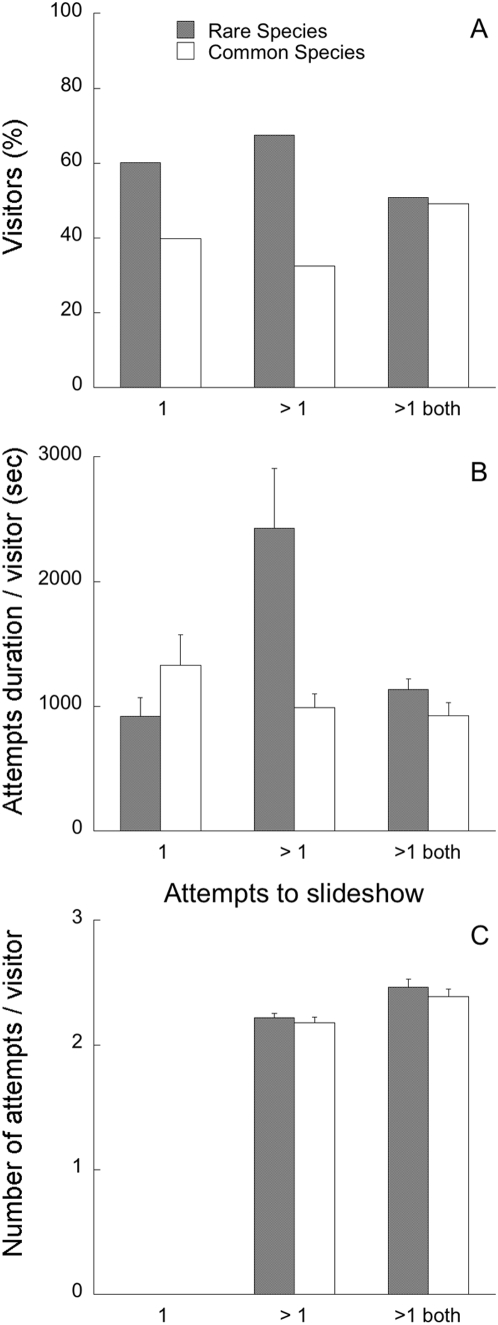
Behaviour of visitors having to choose between slideshows of rare or common species.We show (A) attractiveness, (B) patience and (C) perseverance of visitors. Data comes from visitors who attempted to open only one slideshow type, once (1) or multiple times (>1), or their first choice when they attempted to open both slideshows (>1 both). Error bars indicate standard errors.